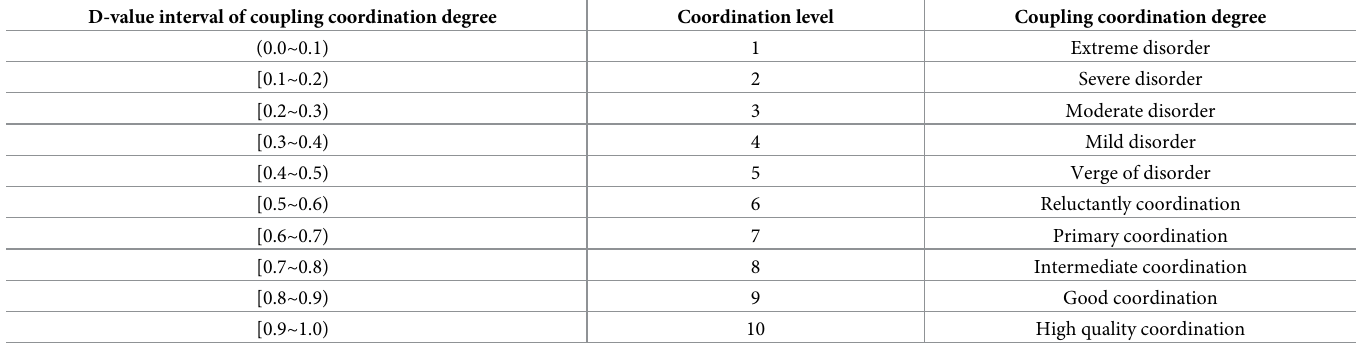
Table 1. Classification standard of coupling coordination